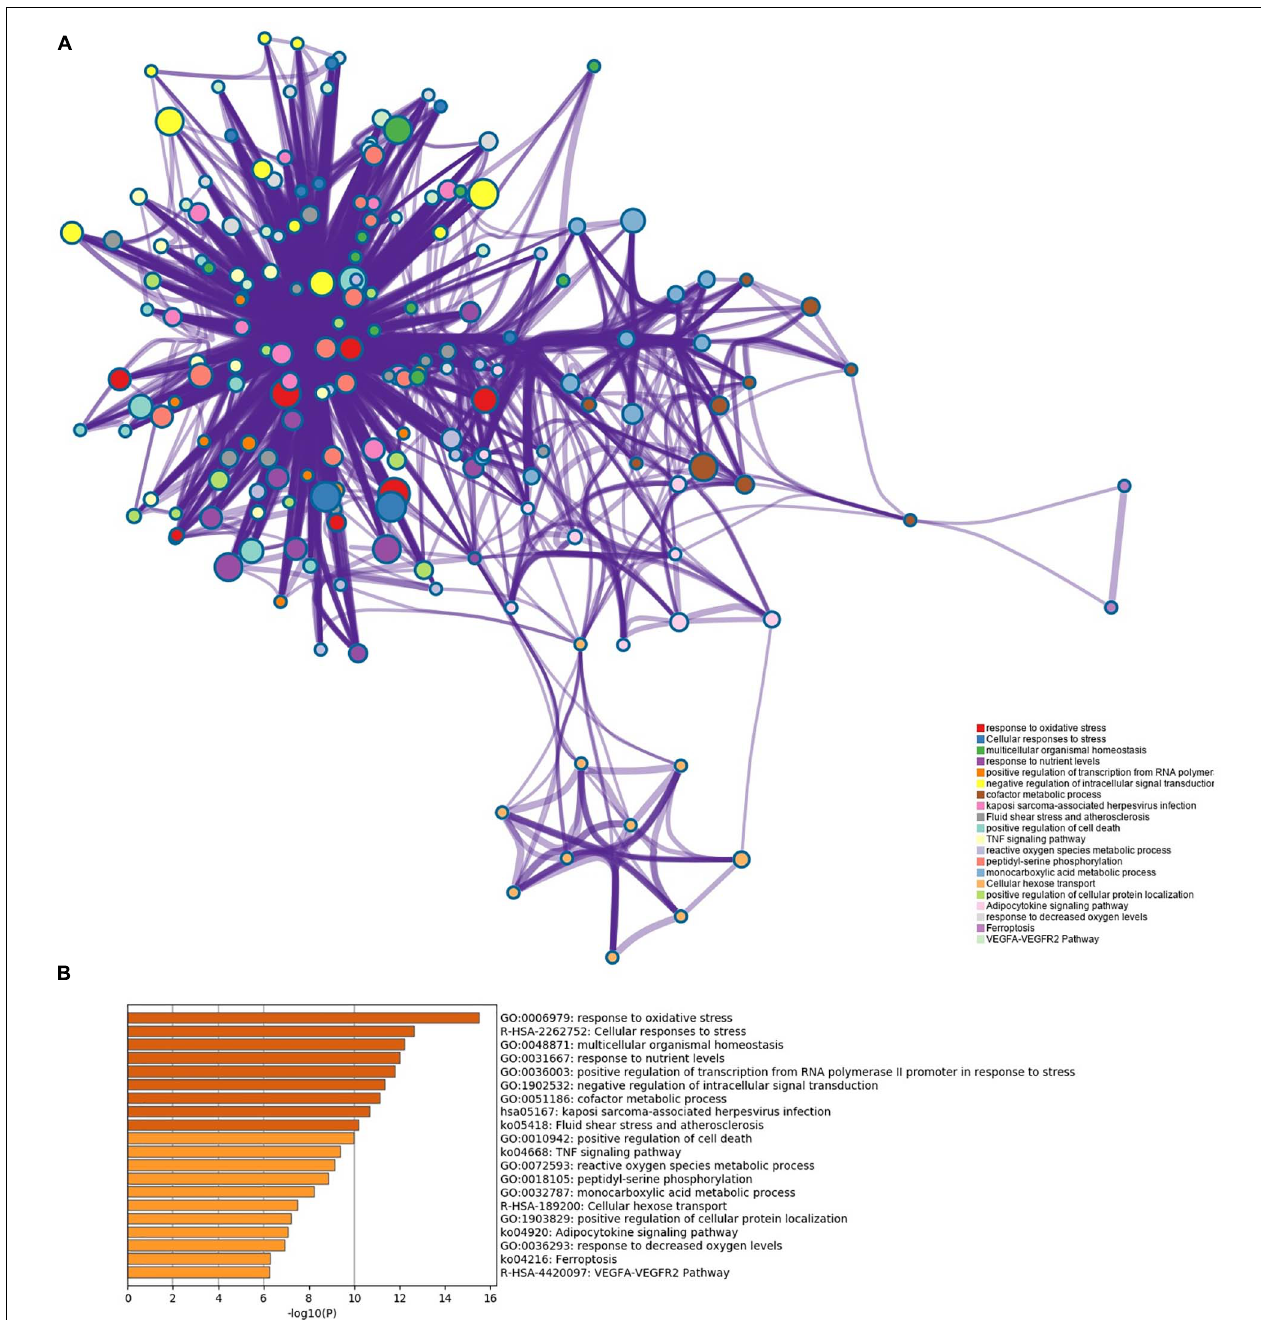
FIGURE 4 | (A) Network of enriched terms. (B) The Metascape drew a bar chart of 20 biological pathways based on the P -value and the percentage of genes, among which biological pathways with P -value < 0.01 are statistically significant. The results showed that the biological processes that were significantly enriched were in response to oxidative